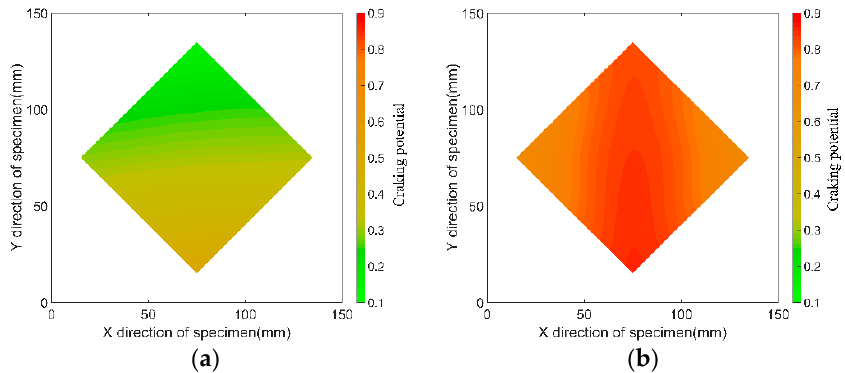
Figure 18. Distribution of the cracking potential of the specimens after 28 days: (a) Sp-3, and (b) St-7.